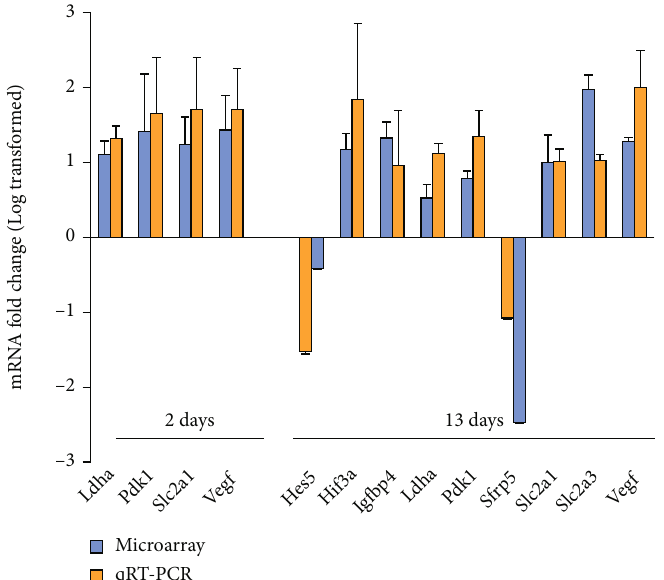
/21% O ) and standard error of mean 2 2